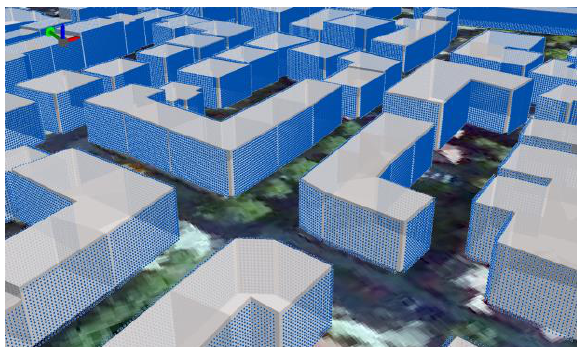
Figure 3. Observer points generated and visualized for the investigated city quarter (green arrow indicates north). Here, a regular grid of 1 m resolution was created